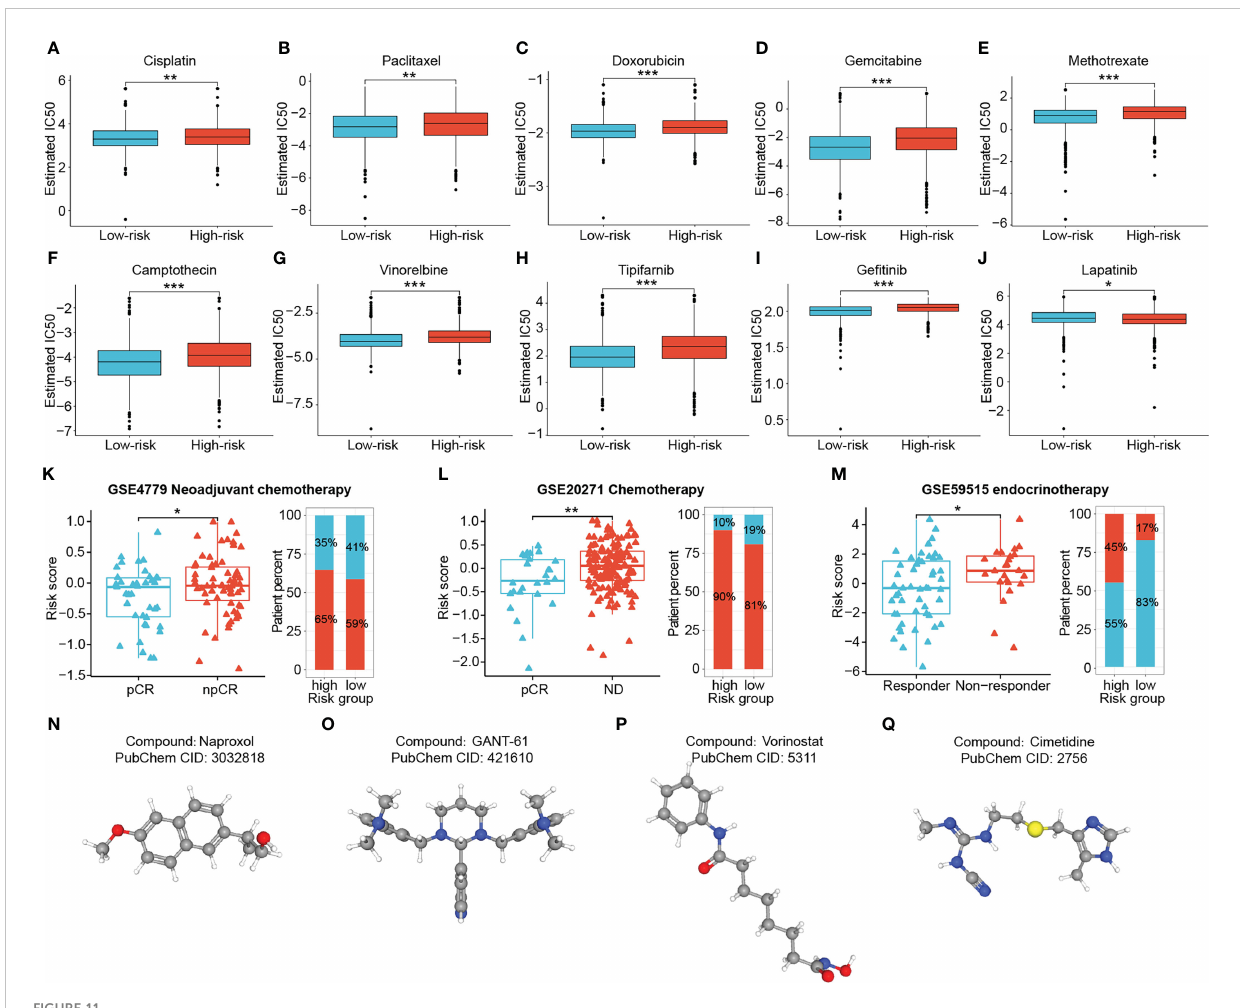
FIGURE 11 Chemotherapy sensitivity prediction and candidate drug exploration. Low-risk patients presented higher sensitivity to Cisplatin (A) , Paclitaxel (B) , Doxorubicin (C) ,Gemcitabine (D) , Methotrexate (E) , Camptothecin (F) , Vinorelbine (G) , Tipifarnib (H) and Ge fi tinib (I) , and lower sensitivity to Lapatinib (J) . (K – M) Three cohorts receiving neoadjuvant chemotherapy, chemotherapy, and neoadjuvant endocrinotherapy validated the predictive performance of the signature. (N – Q) (*P < 0.05, **P < 0.01, ***P < 0.001). (ns: not signi fi cant, * P < 0.05, ** P < 0.01, *** P <